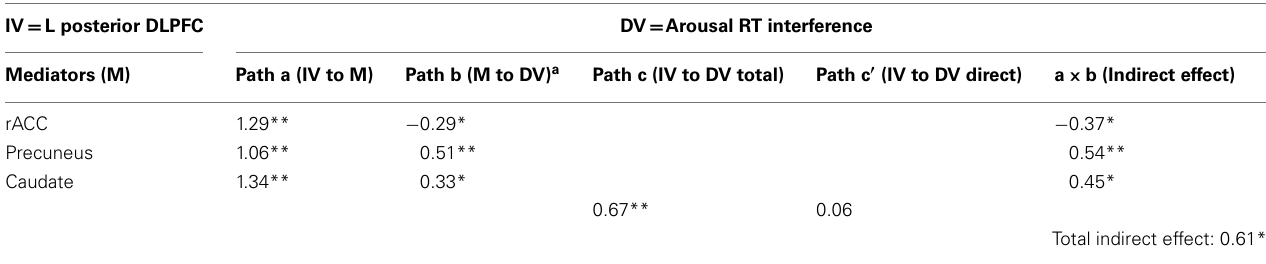
Table 4 | Summary of multiple mediation